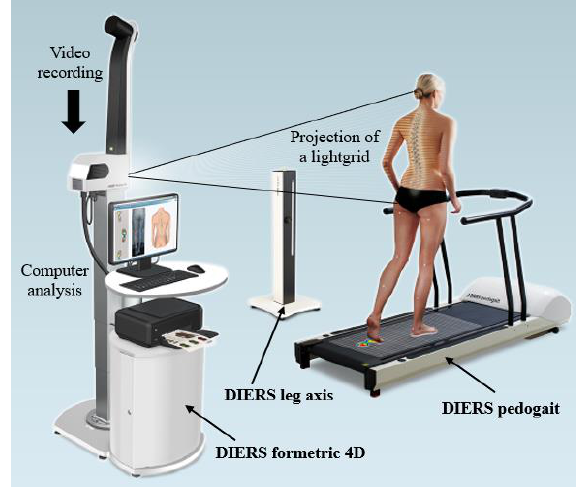
Figure 2. System DIERS (own study based on: [24]).